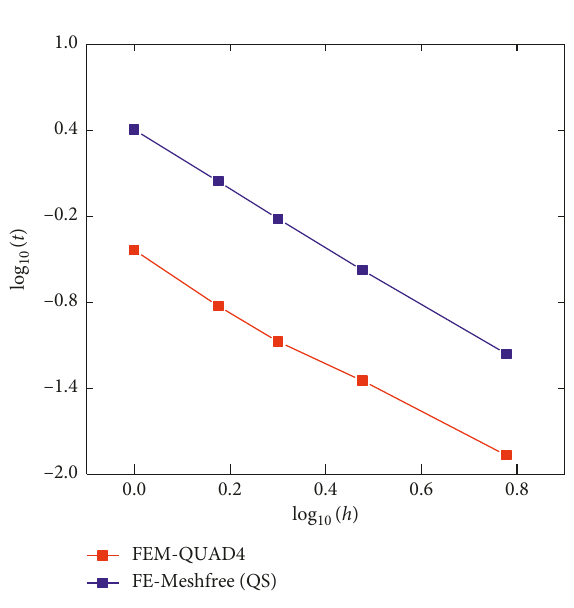
Figure 9: Energy error norm convergence.